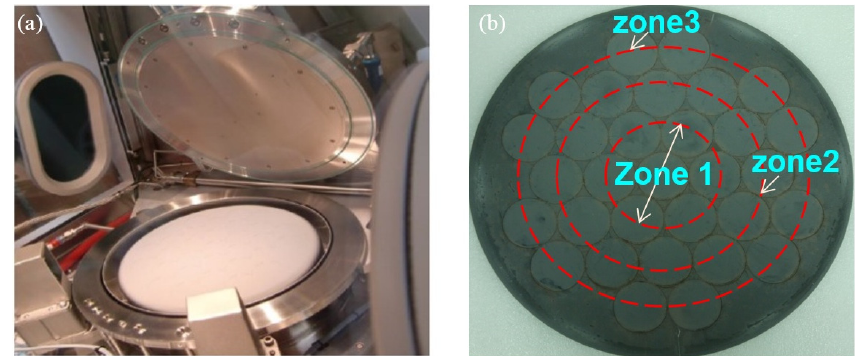
Figure 1. ( a ) Aixtron Crius I vertical close-spaced MOCVD reactor (ITRI, Taiwan); ( b ) Top view of the susceptor in the reactor.